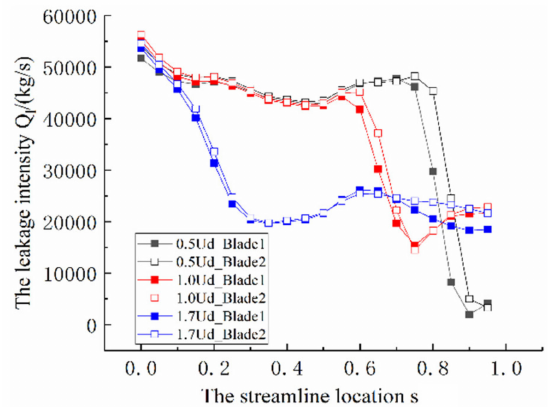
Figure 14. Distribution of the calculated leakage intensity.